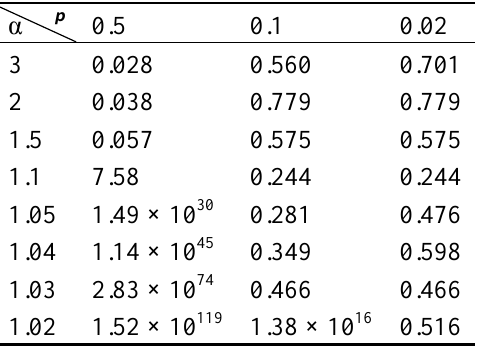
Table 1. Sample l p averages calculated by Algorithm 1 with window size 2 q + 1 = 7 for 2000-point data set from Distribution 2.